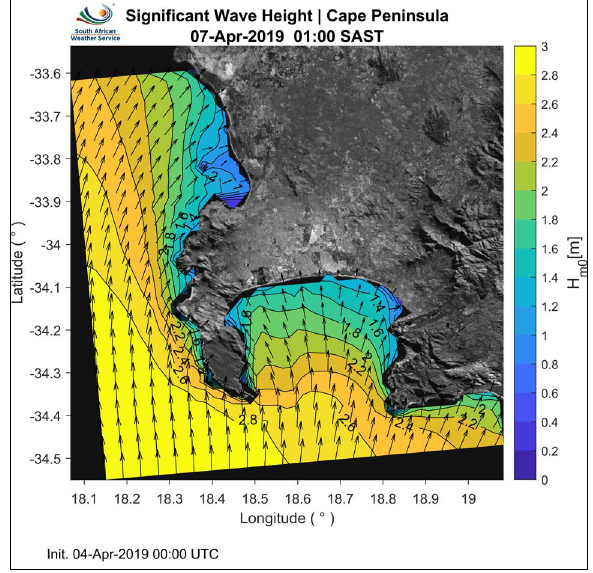
Figure 2: High-resolution significant wave height forecast for the Cape